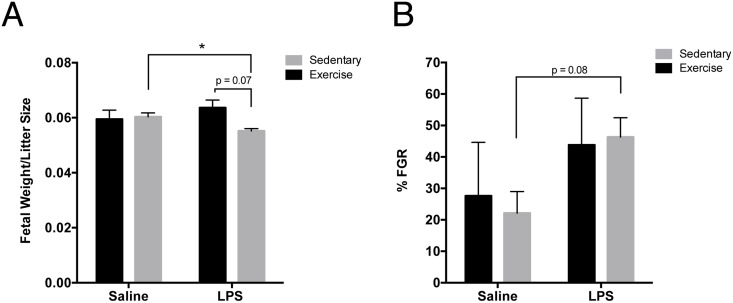
Exercise prevented LPS-induced fetal growth restriction.LPS significantly reduced fetal weights/litter size in sedentary rats (Se+LPS), whereas fetal weights in exercised rats treated with LPS (Ex+LPS) trended (p = 0.07) towards being significantly higher than in the Se+LPS cohort (A). Although the proportion of growth restricted fetuses trended towards being increased in Se+LPS rats than in Se+Saline rats [7], exercise did not significantly alter this proportion in the present study (B). FGR, fetal growth restriction. Ex+LPS (number of pups = 41, litter size varied 5 to 11), Ex+Saline (number of pups = 63; range in litter size = 4–19), Se+LPS (number of pups = 258), Se+Saline (number of pups = 305) (A); Ex+LPS (n = 5), Ex+Saline (n = 5), Se+LPS (n = 28), Se+Saline (n = 22) (B).